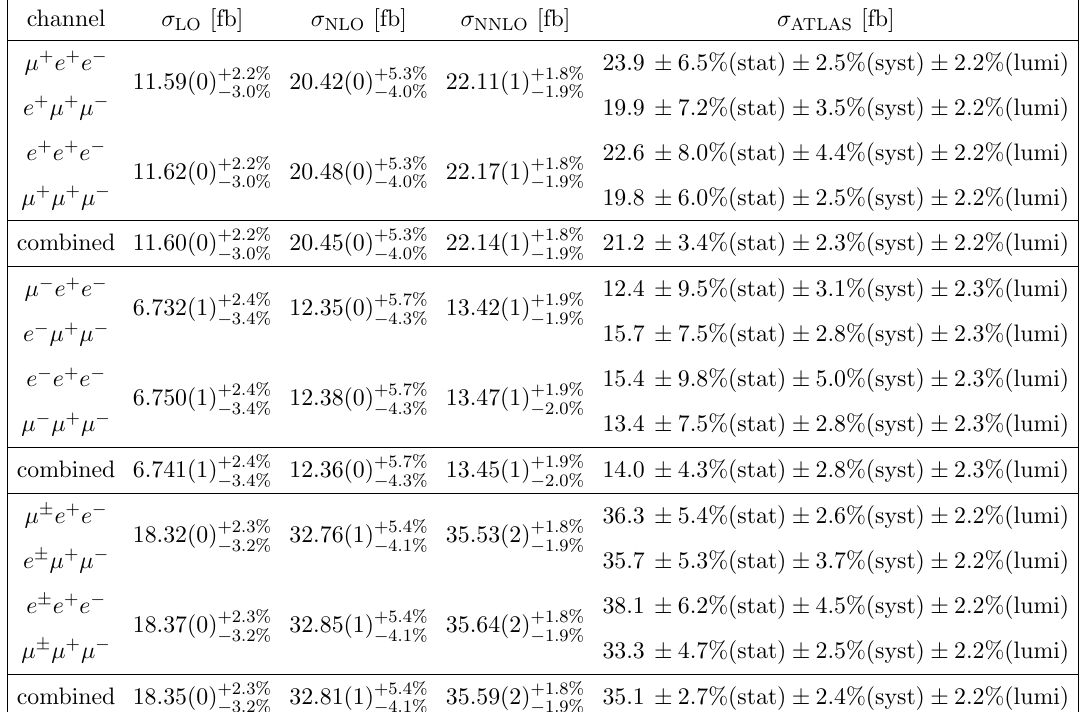
Table 2 . Fiducial cross sections for ATLAS 8 TeV. Note that due to the (cid:13)avour-unspeci(cid:12)c lepton cuts the theoretical predictions are (cid:13)avour-blind, which is why the results are symmetric under e (cid:22) exchange. The available ATLAS data from ref. [6] are also shown. \Combined" refers to the $ average of di(cid:11)erent lepton